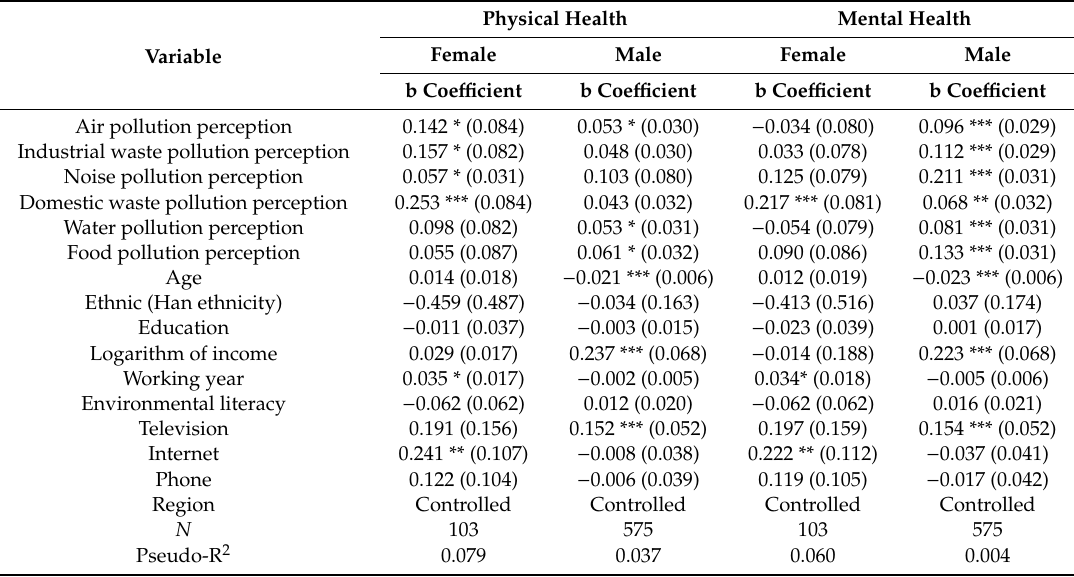
Table 3. Influences of ERP on migrant construction workers’ physical and mental health for di ff erent gender